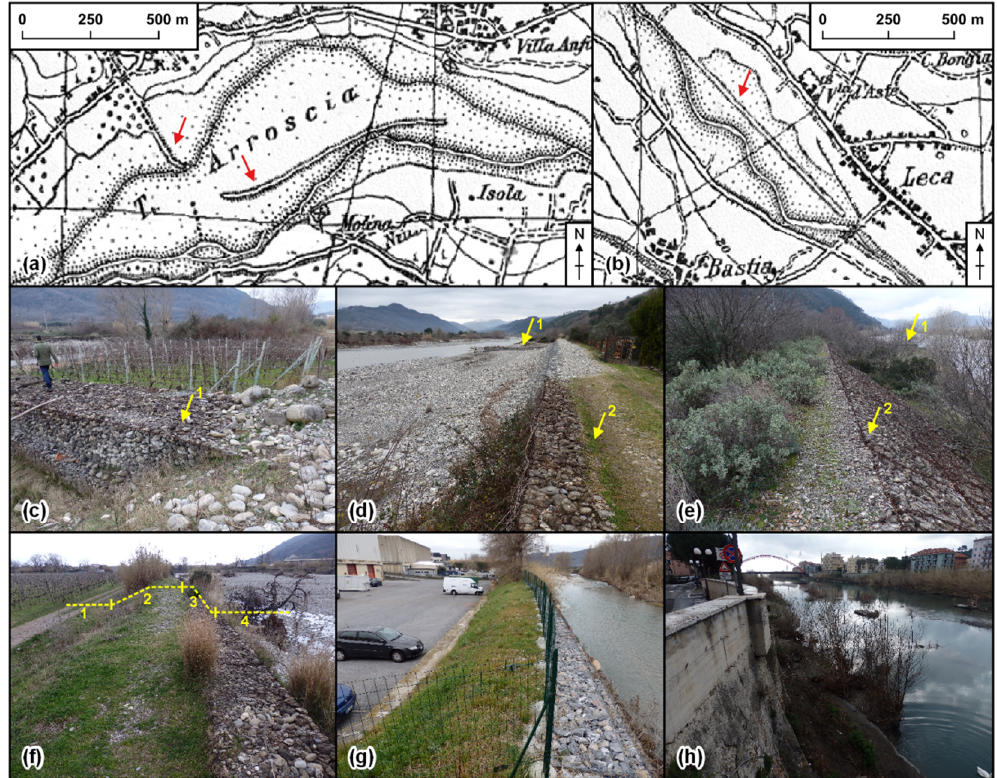
Figure 13. Channelization structures depicted on the 1930 map along the ( a ) Arroscia (reach A3) and ( b ) Neva (reaches N1 and N2) rivers. The present-day channelization structures along reaches ( c ) A1, ( d ) A2, ( e ) A3, ( f ) A3, ( g ) N1, and ( h ) C2. The yellow arrows marked with 1 and 2 indicate groynes and longitudinal bank protections, respectively. In ( f ), the dotted line represents a schematic topographic section of the most common channelization structure in reaches A2, A3, N2, and C1. 1: ground level of cultivated fields; 2: embankment for flood protection; 3 gabions for erosion protection; 4: active channel. Photographs: Andrea Mandarino.